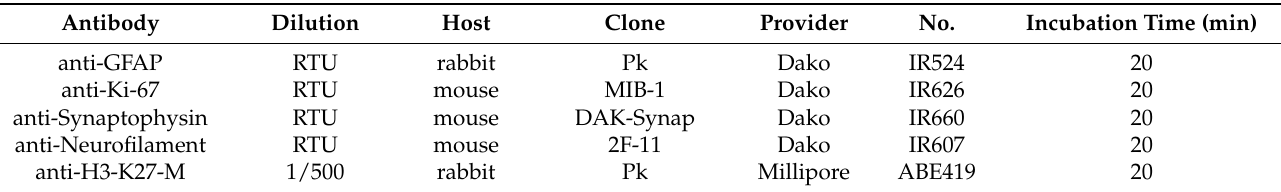
Table 2. Antibodies used in IHC analysis of CNS tumors.